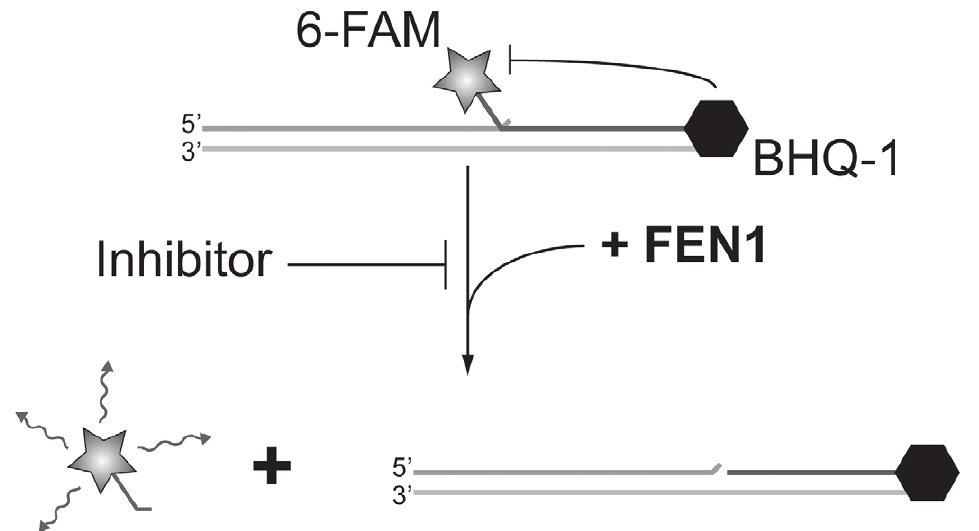
Figure 2. Screening for FEN1 inhibitors invitro . Schematic representation of the fluorescence-based assay employed to identify FEN1 inhibitors. In the absence of inhibitor, FEN1 cleaves the 5 9 flap to which the 6-FAM fluorophore is attached, allowing it to diffuse away from the BHQ-1 quencher and fluoresce. Activity is read as increasing fluorescence over time.